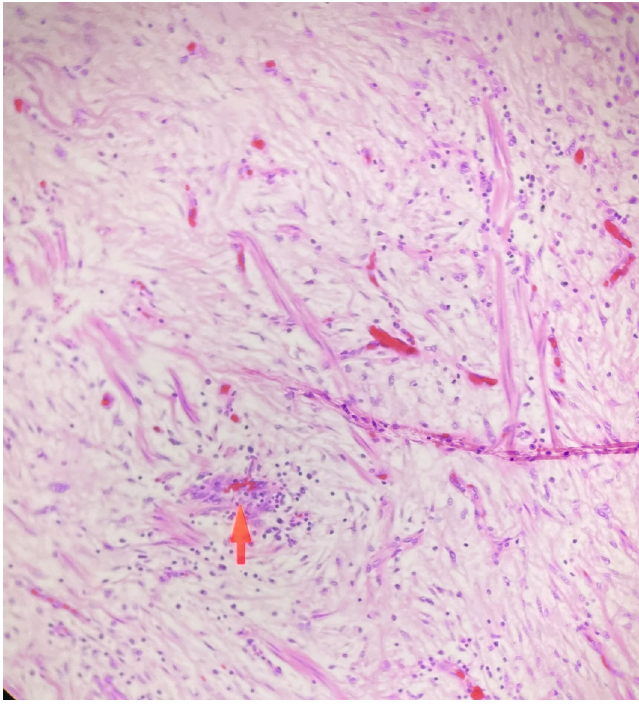
Figure 4: A hypocellular tumor comprising of myxoid stroma with areas of abundant